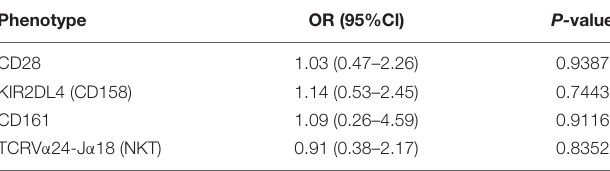
TABLE 6 | Effects of MedDiet on co-stimulatory